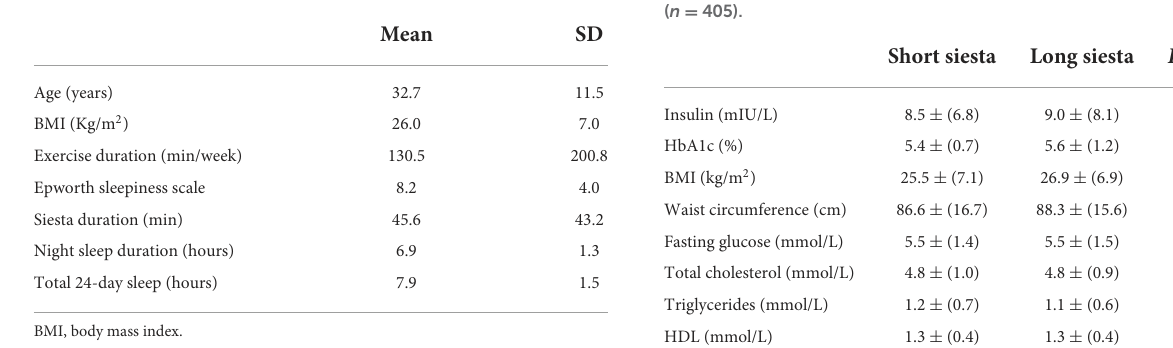
TABLE 1 Demographics of the study sample ( n = 405). TABLE 2 Metabolic comparison between short and long siesta